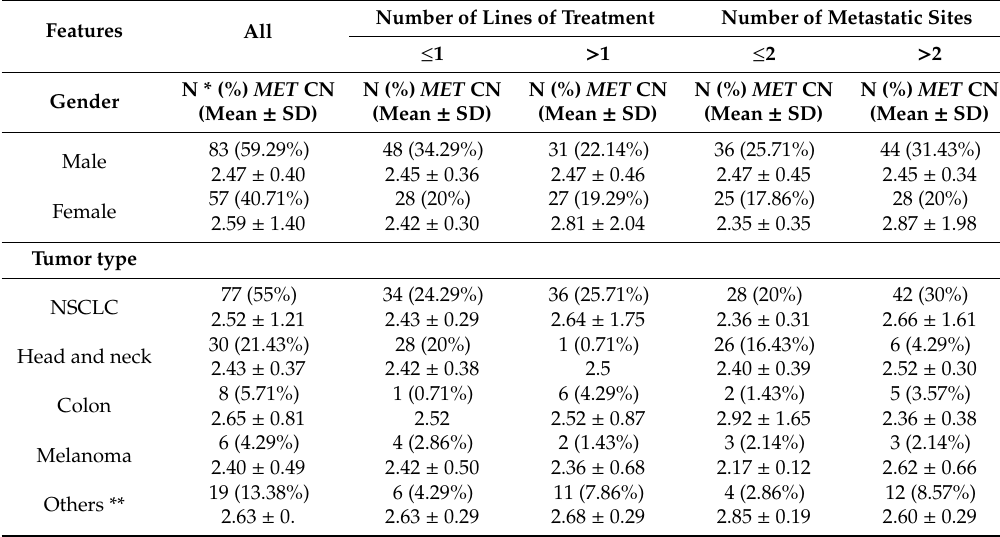
Table 1. Baseline demographics and clinical characteristics of the metastatic cancer patient population analyzed for MET